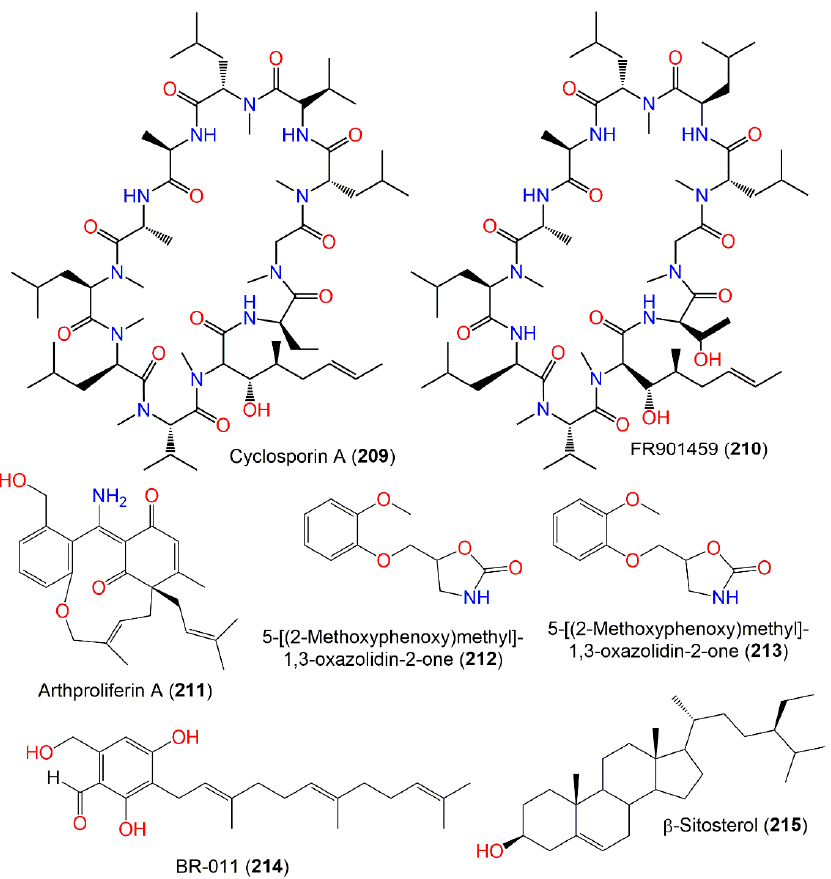
Figure 26. Structures of cyclosporins ( 209 and 210 ), nitrogenous compounds ( 211 – 213 ), phenolic ( 214 ), and sterol ( 215 ) reported from S. chartarum . ( 214 ), and sterol ( 215 ) reported from S. chartarum